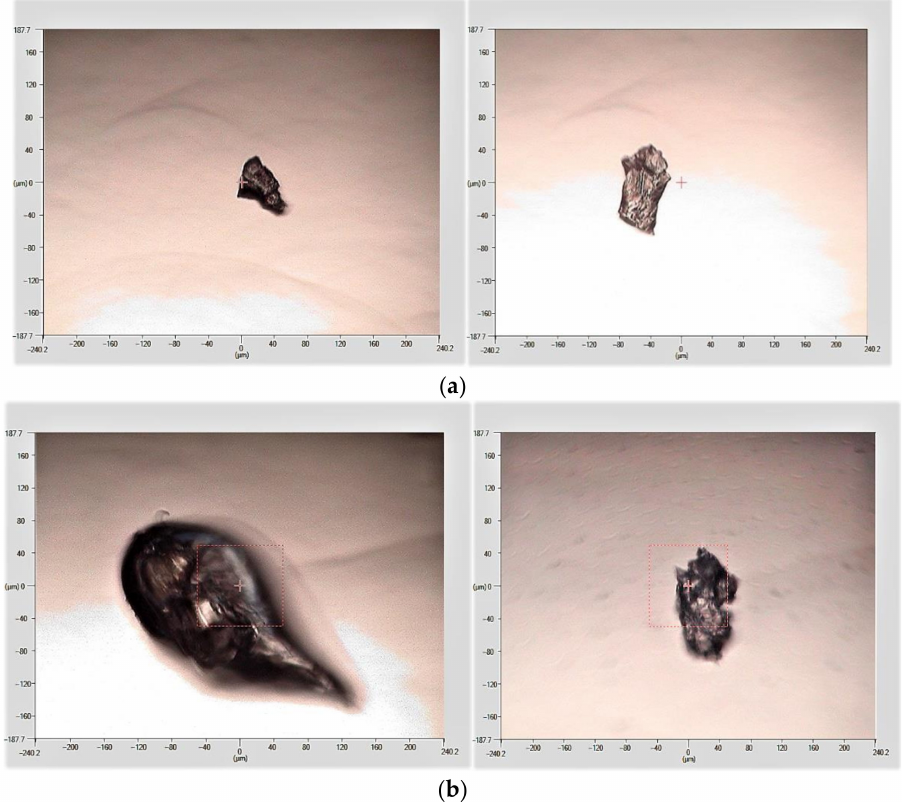
Figure 3. FTIR microscope imaging of microplastics extracted from ( a ) soil, ( b ) road.